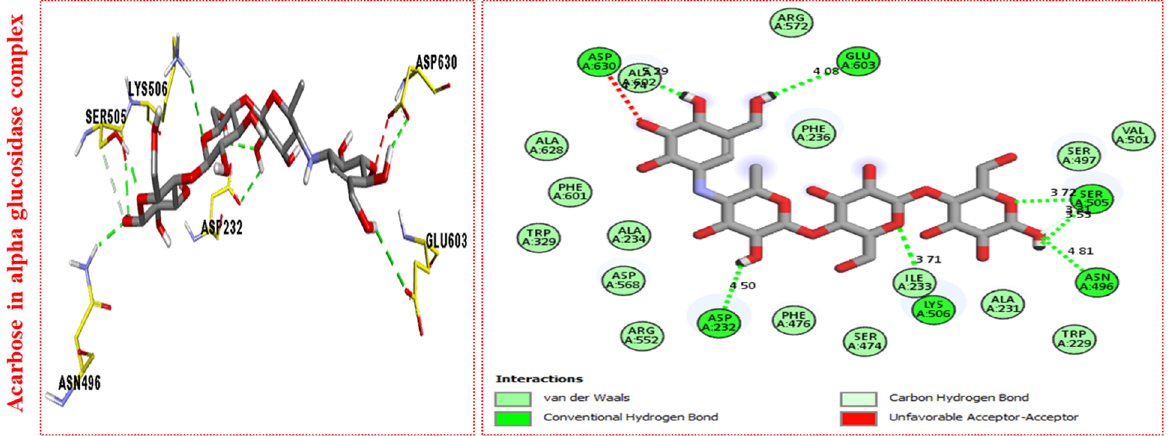
Figure 6. Protein–ligand interaction profiles against α -Glucosidase represent the surface of the corresponding enzyme. The PLI profile for acarbose.